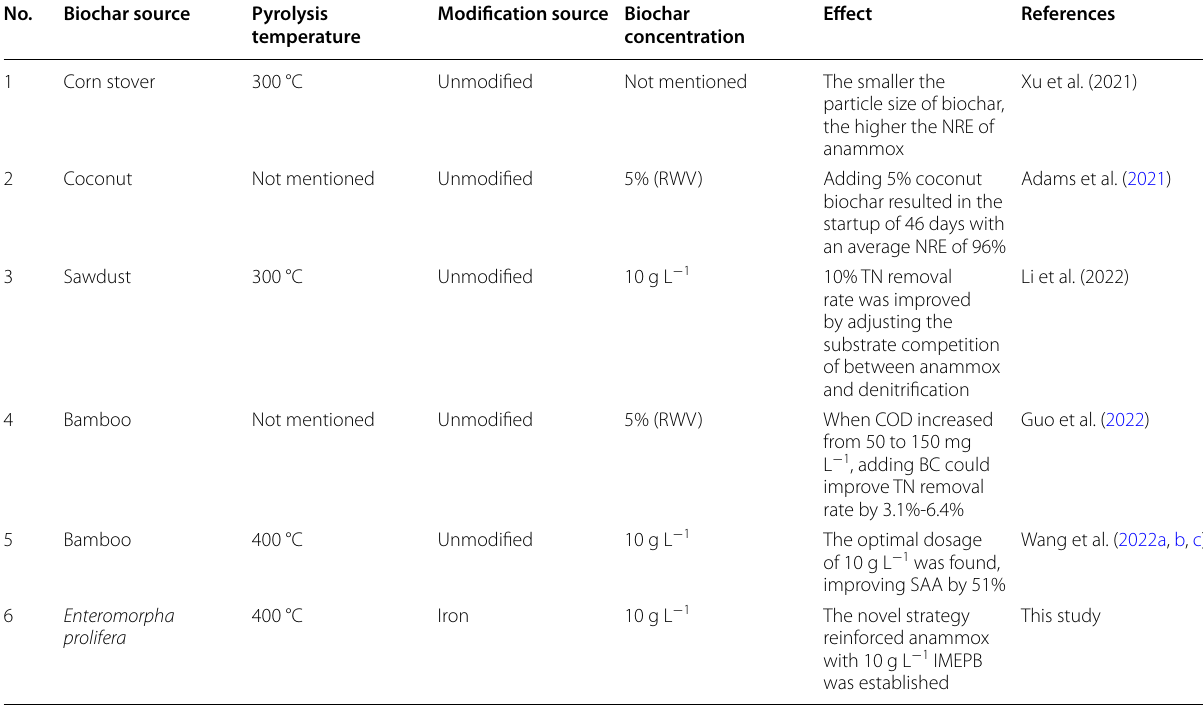
RWV Reactor work volume, BC Bamboo charcoal